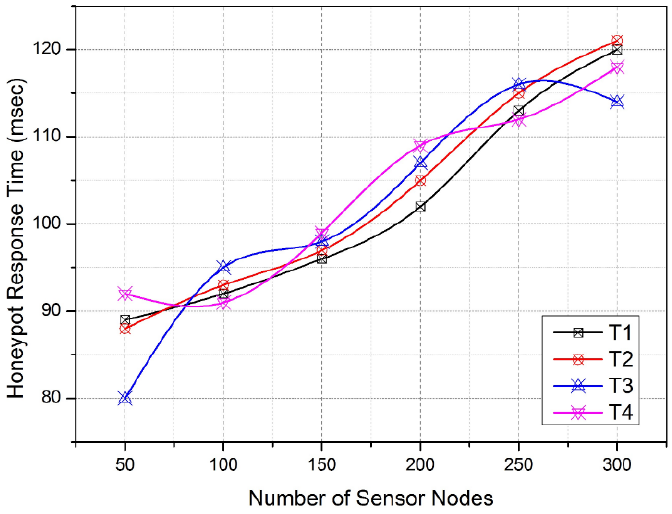
Figure 10. Honeypot Response Time.